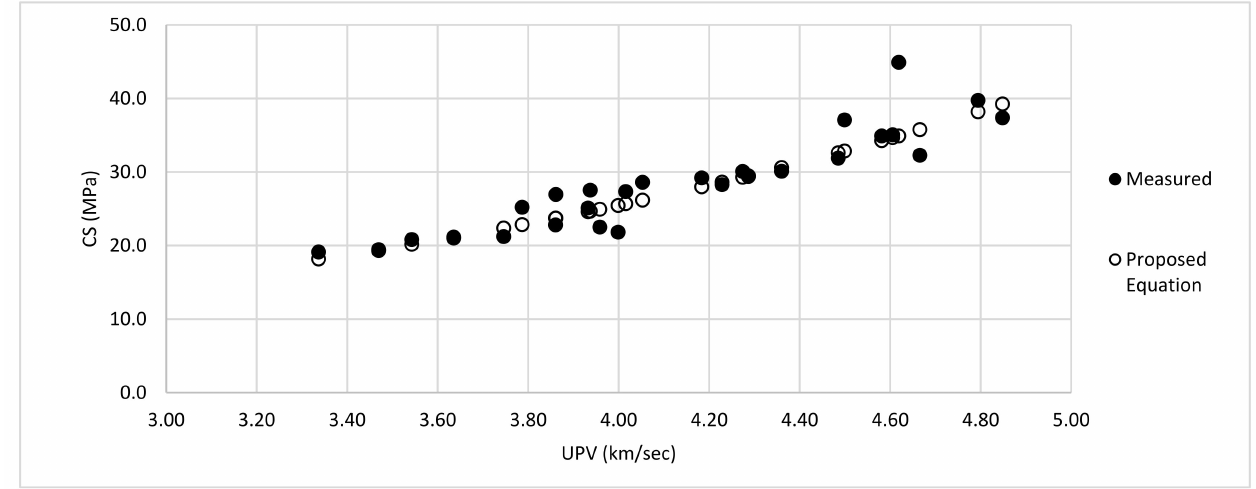
Figure 5. PFRC’s measured compressive strength (CS) vs. Equation (13) (the proposed